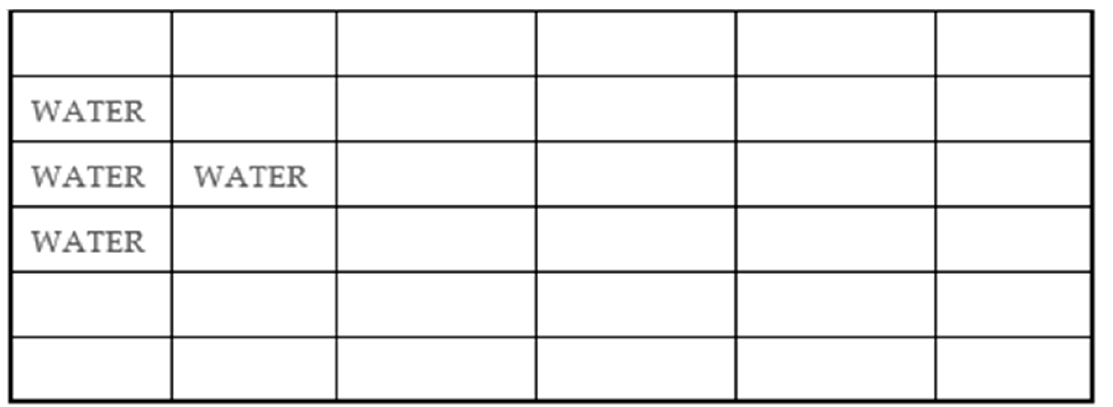
Figure 7. Best match tempmem <x> from the Causal Memory. Module of the starting WNM’ <x> (Equation (88)).